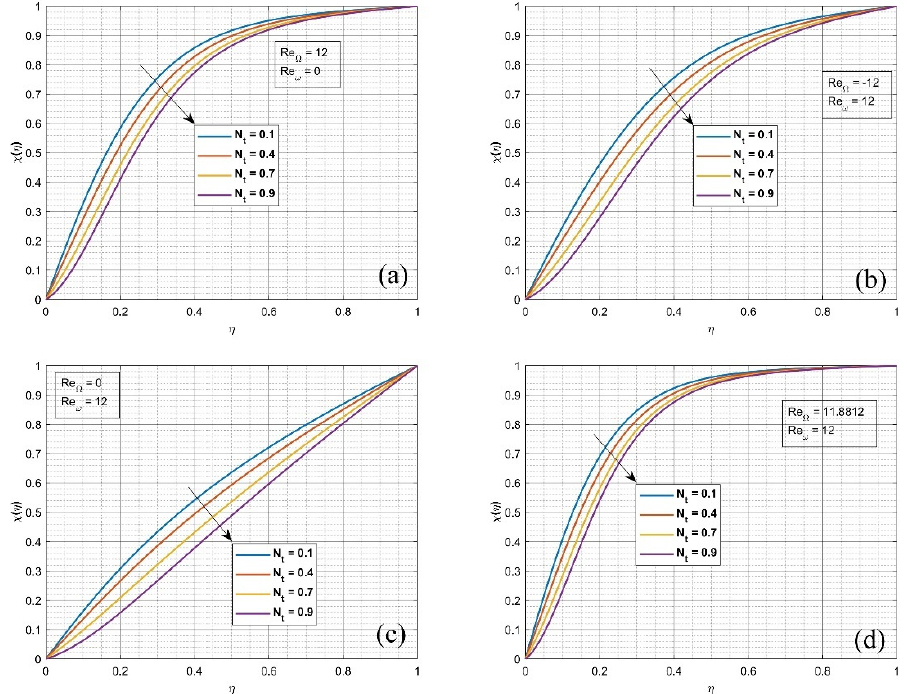
Figure 4. ( a – d ): Influence of thermophoretic parameter on χ ( η ) ; ( a ) the scenario between a rotating cone and stationary disk; ( b ) the scenario between a counter-rotating cone; ( c ) the scenario between a rotating disk and a stationary cone; ( d ) the scenario between a co-rotating cone and disk.